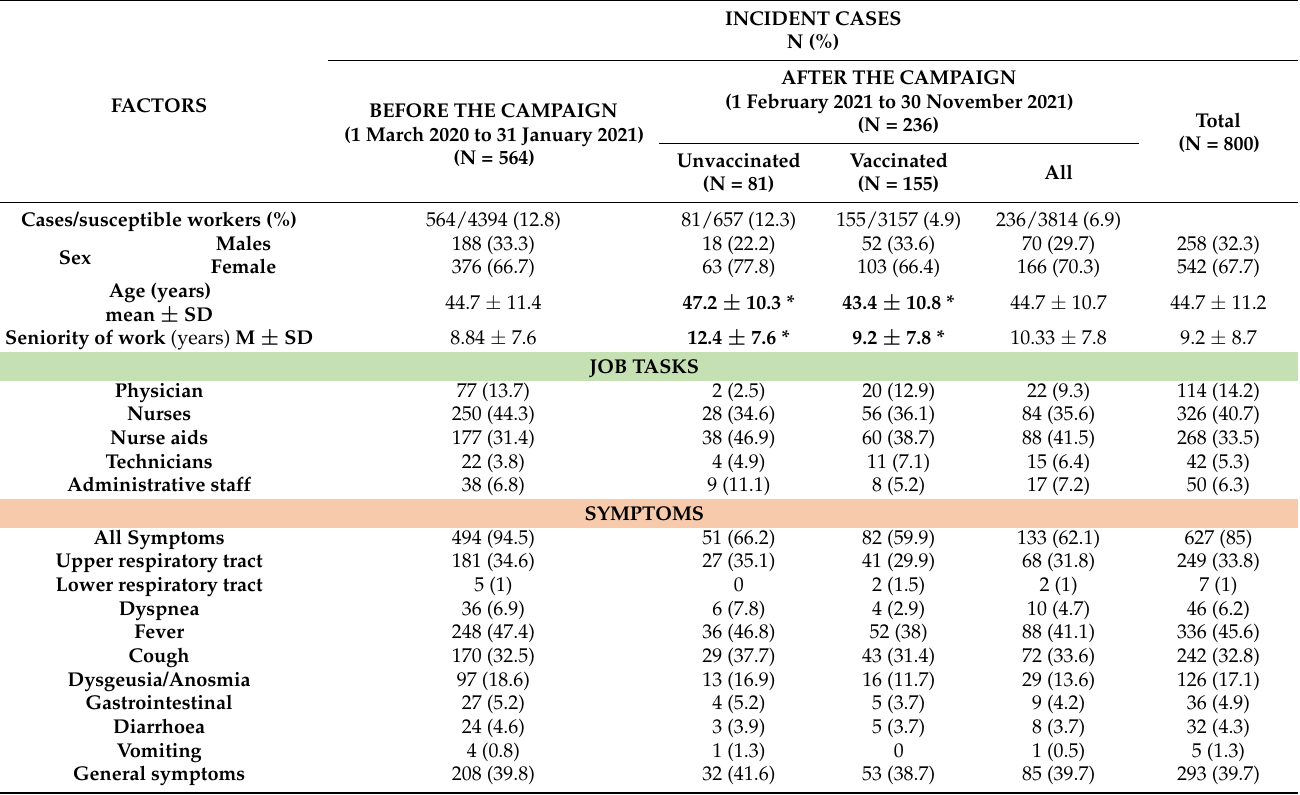
Table 2. Distribution of incident SARS-CoV-2 infections among healthcare workers by explanatory factors, before and after the COVID-19 vaccination campaign. Number (N), percentage